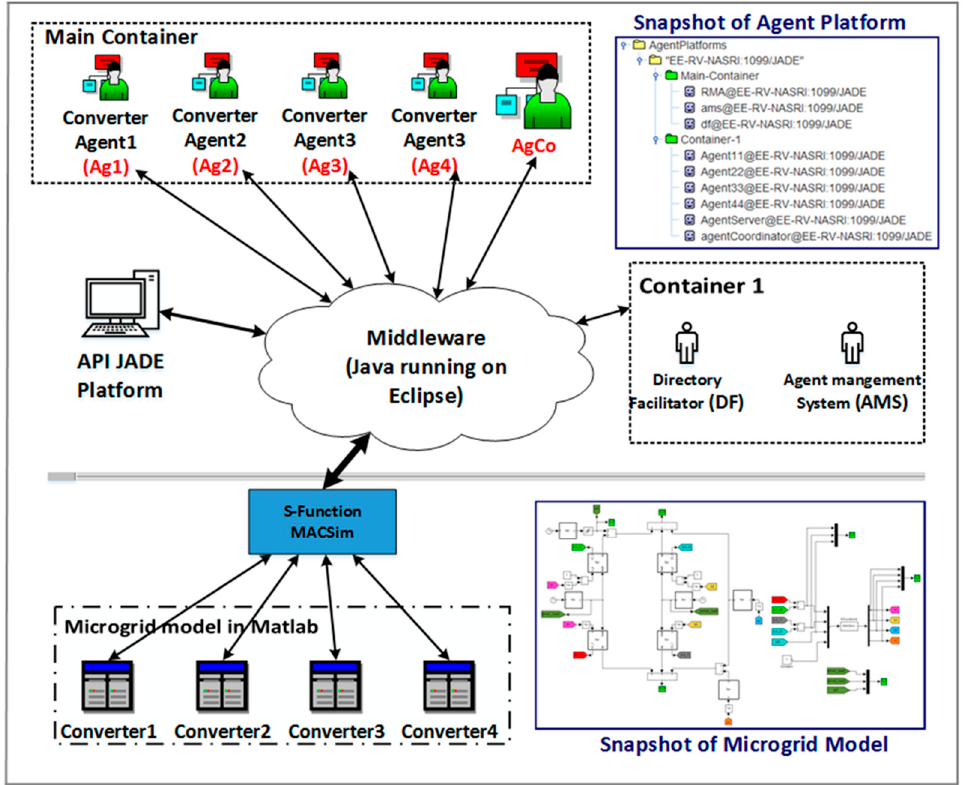
Figure 6. The integrated agent-based system, including a microgrid modeled in Simulink and MAS (Multi-agent System), programmed in JADE (Java Agent DEvelopment Framework), and communicating through the MACSim toolbox.